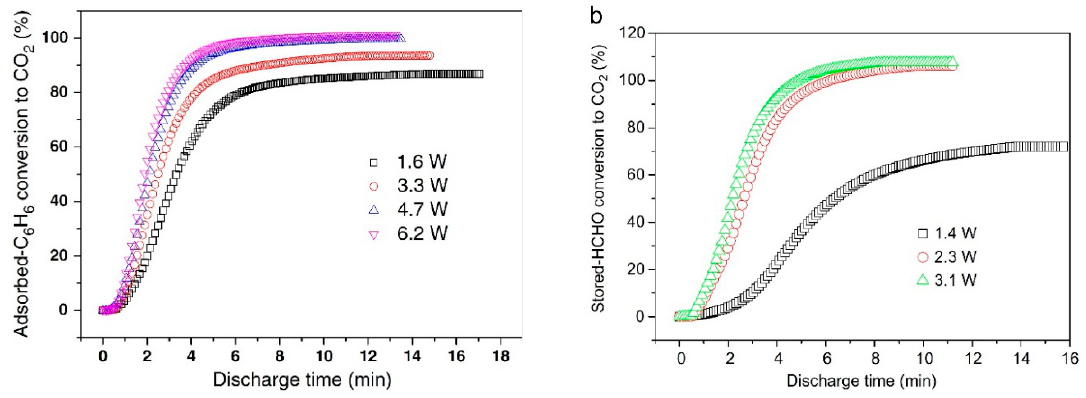
Figure 8. ( a ) Adsorbed-benzene conversion to CO 2 over Ag/HZSM-5